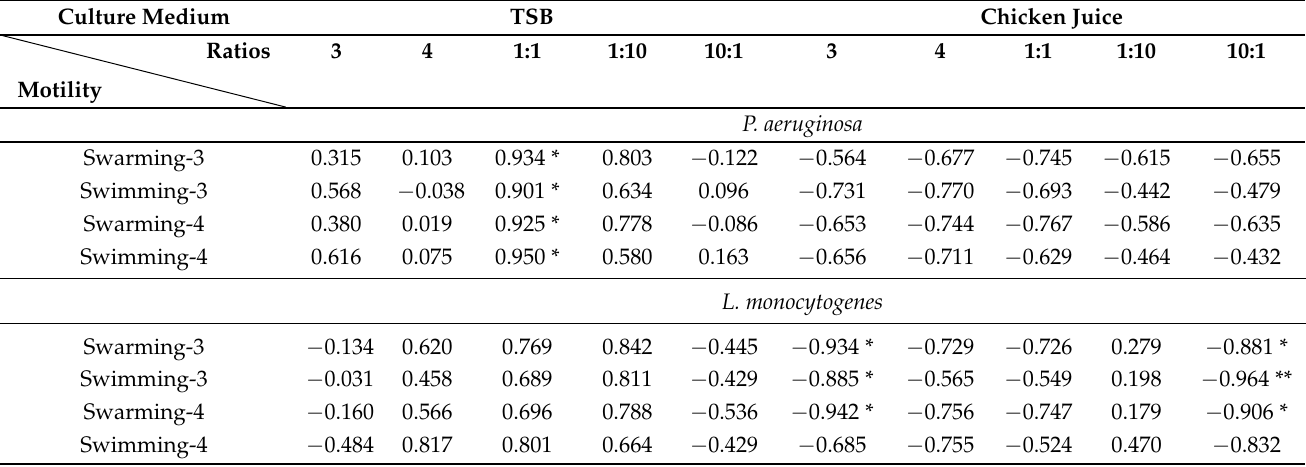
Table 1. The correlation coefficient between motility and biofilm formation of P. aeruginosa and L. monocytogenes at 26 ◦